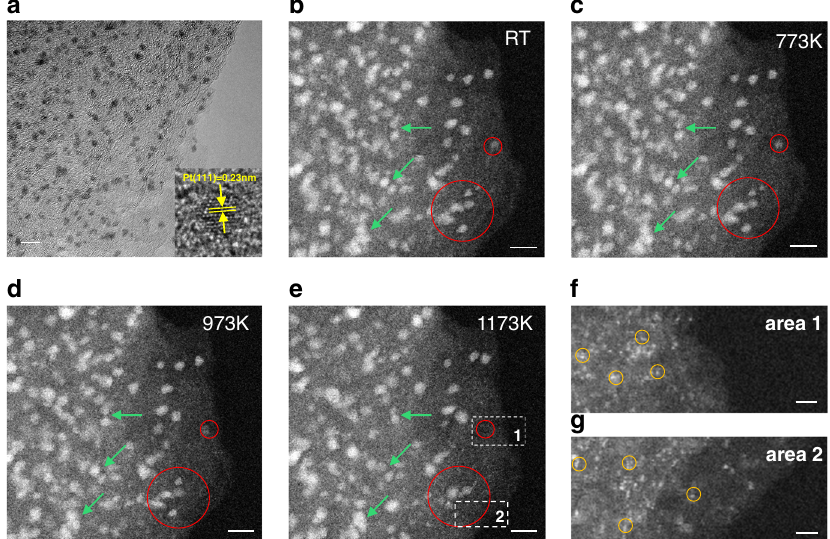
Fig. 7 Thermal stability studies of Pt nanoparticles on CNF supports through in situ annealing. a Large scale TEM image of nanoparticles sitting on wrinkled edges (inset shows HRTEM image of a Pt cluster). HAADF-STEM images of Pt nanoparticles on CNF substrate captured after annealing at different temperatures: b RT, c 773 K, d 973 K, and e 1173 K. The particles are highly stable with no obvious aggregation. Red circles in each image depict nanoparticles that mostly maintain their stability during heating from RT to 973 K, while some of the nanoparticles vanish at 1173 K. Scale bars are 5 nm. The images in ( f , g ) show the high magni fi cation view of areas 1 and 2 (corresponding to the areas marked in e ), where nanoparticles disappear. Interestingly, high population of single atoms (some of them are indicated by the yellow circles) are observed. Scale bars in f and g are 2 nm.